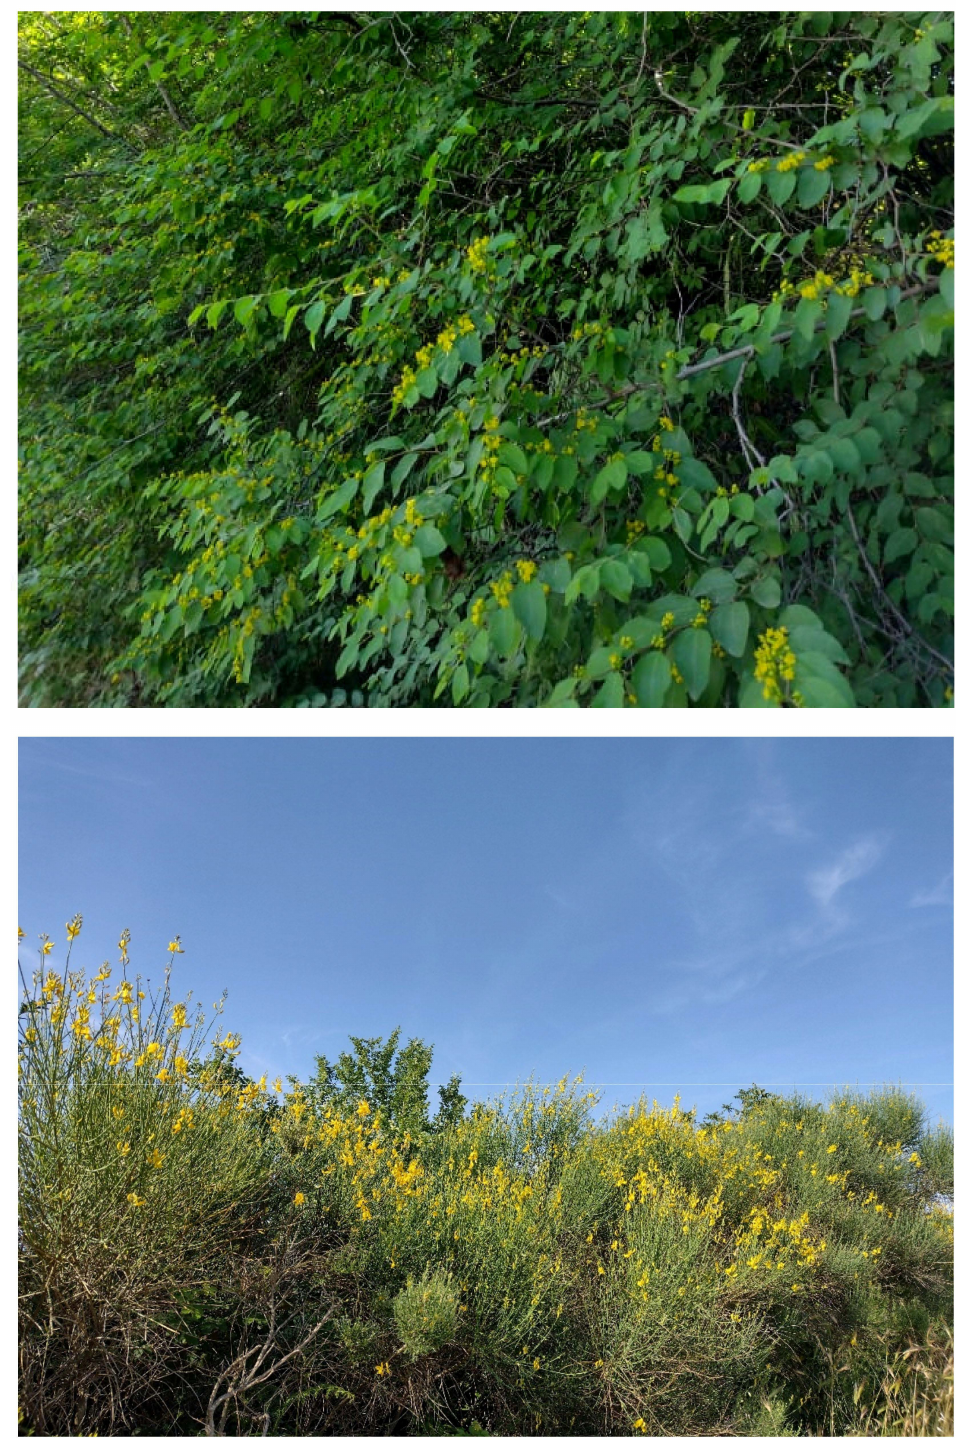
Figure 19. Scrub vegetation in the nemoral zone (Crataego-Prunetea): Paliurus spina-christi community, locality Caffarella (top photo); Spartium junceum community, locality Tor Marancia (bottom